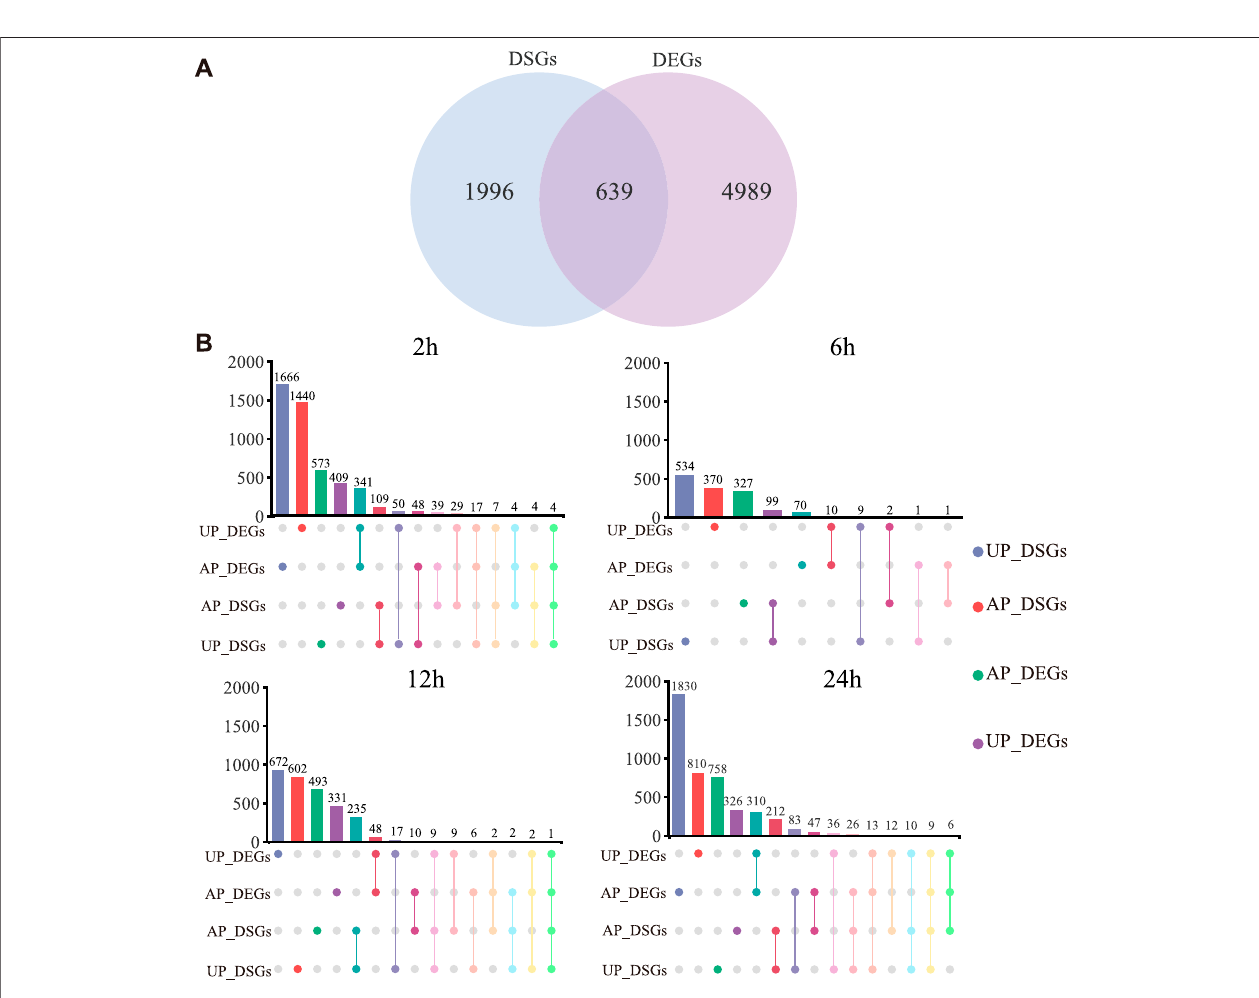
FIGURE 4 | Comparative analysis of differentially spliced genes (DSGs) and differentially expressed genes (DEGs) in G. uralensis at different time points under drought stress. (A) Comparative analysis of overlapping DEGs and DSGs under all drought conditions. (B) Number of DSGs and DEGs in AP and UP, and those overlapping between AP and UP, at different time points during the drought